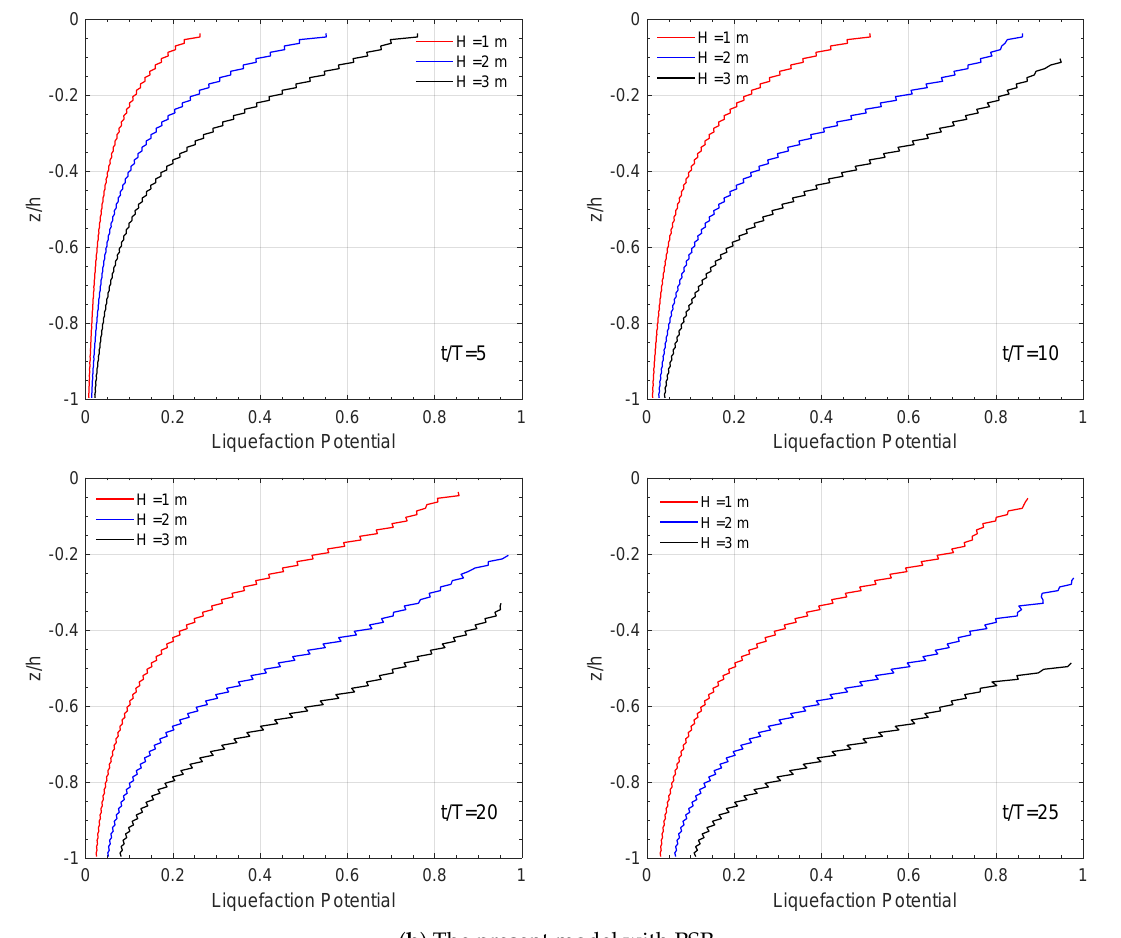
Figure 11. Effect of wave height H on the vertical distribution of liquefaction potential on z = − 5 m at four typical time points. ( a ) The original PZIII model without PSR (principal stress rotation) and ( b ) the present model with PSR.